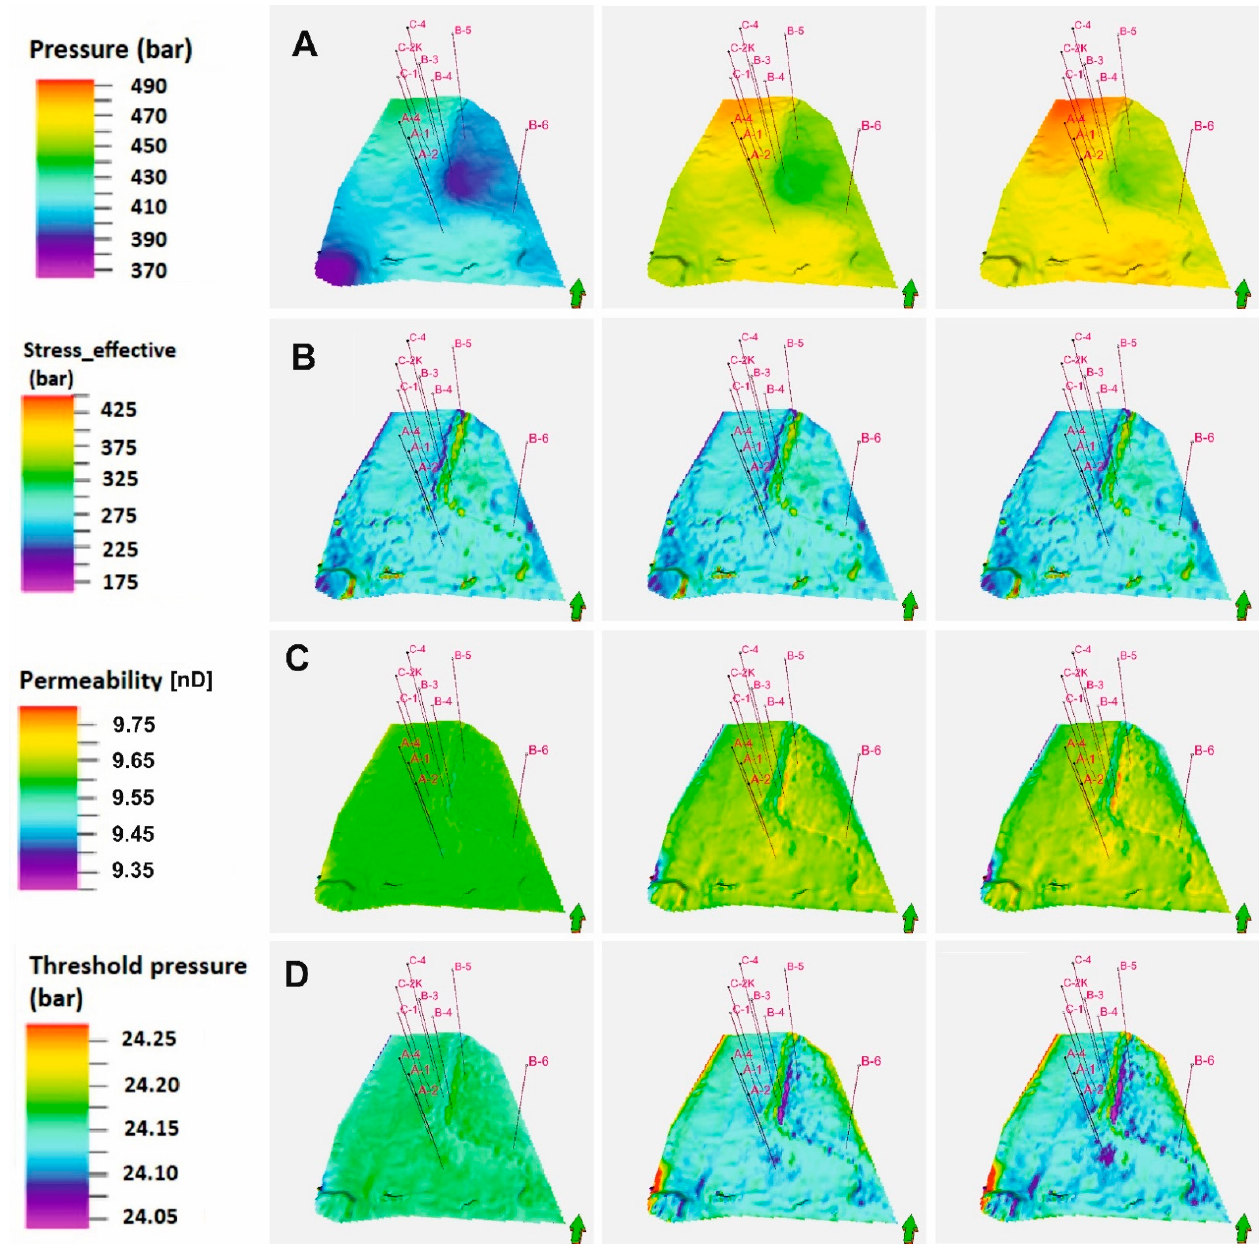
Figure 22. Spatial distributions of: ( A )—pore pressure, ( B )—effective minimum horizontal stress ( σ h ), ( C )—permeability (k), and ( D )—threshold pressure in the sealing rock in the basal anhydrite (A2) at the end of hydrocarbons production (2020 year—left column), in the process on CO 2 injection (2056 year—middle column), and at the end of CO 2 injection (2100 year—right column).